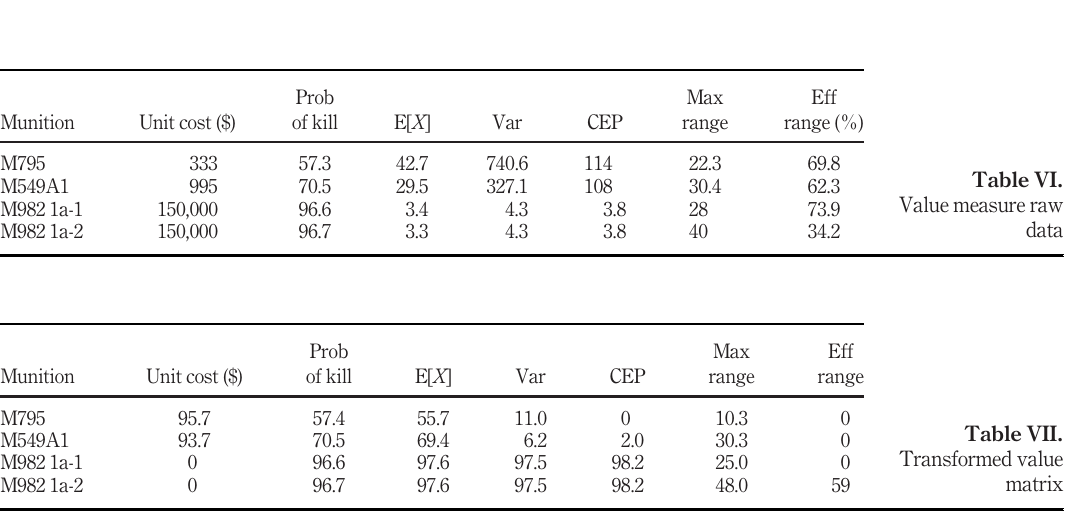
Figure 10. Expected number